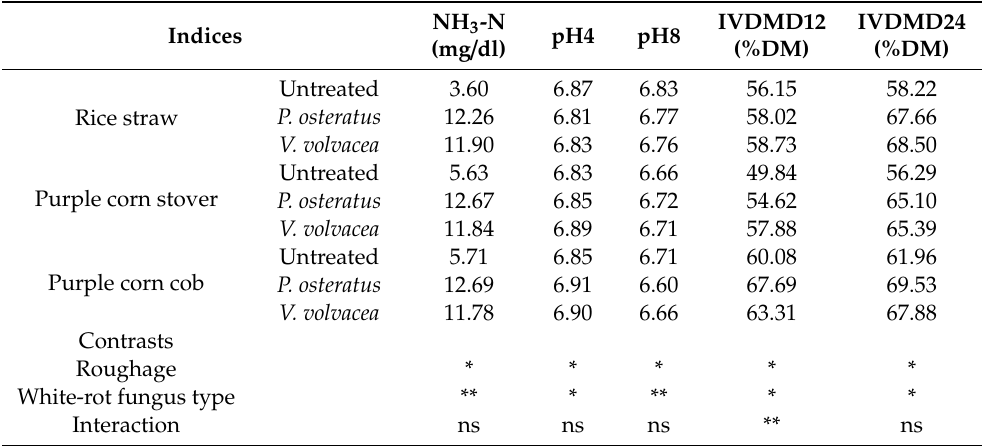
Table 4. E ff ect of roughage fermentation with white-rot fungus type on rumen ecology and in vitro